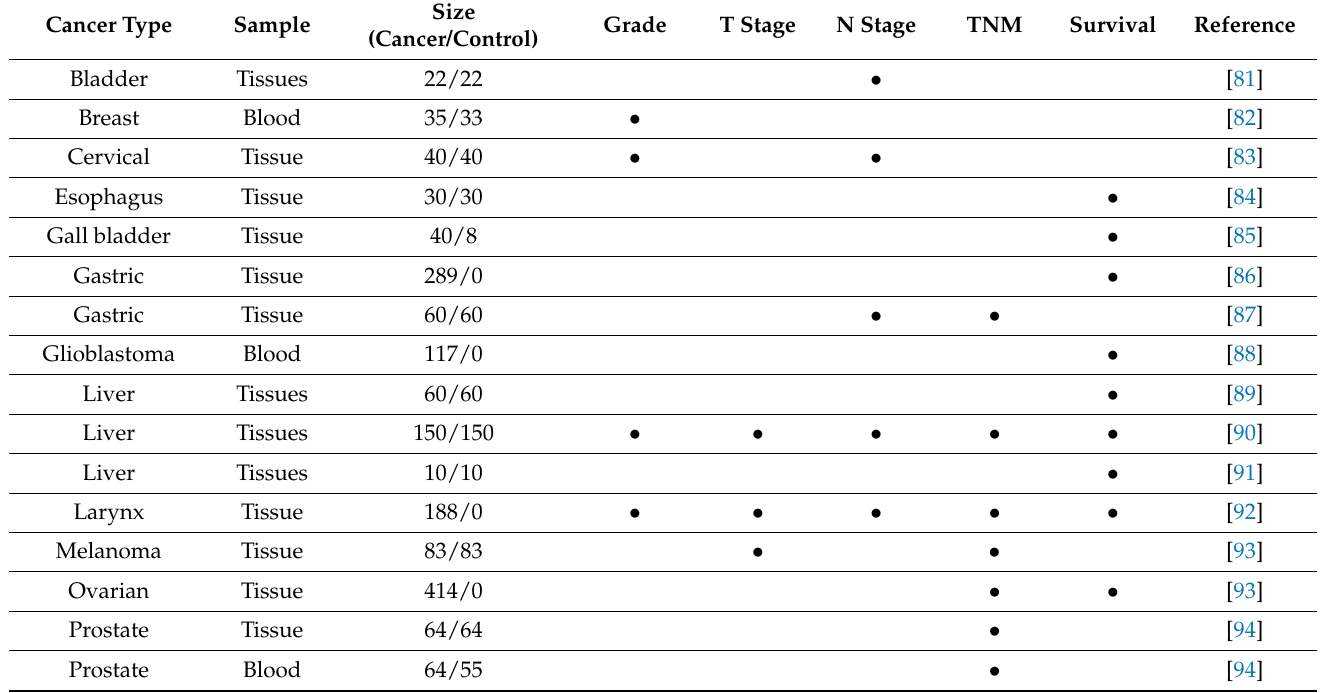
Table 4. Association between miRNA and clinical parameters in cancer